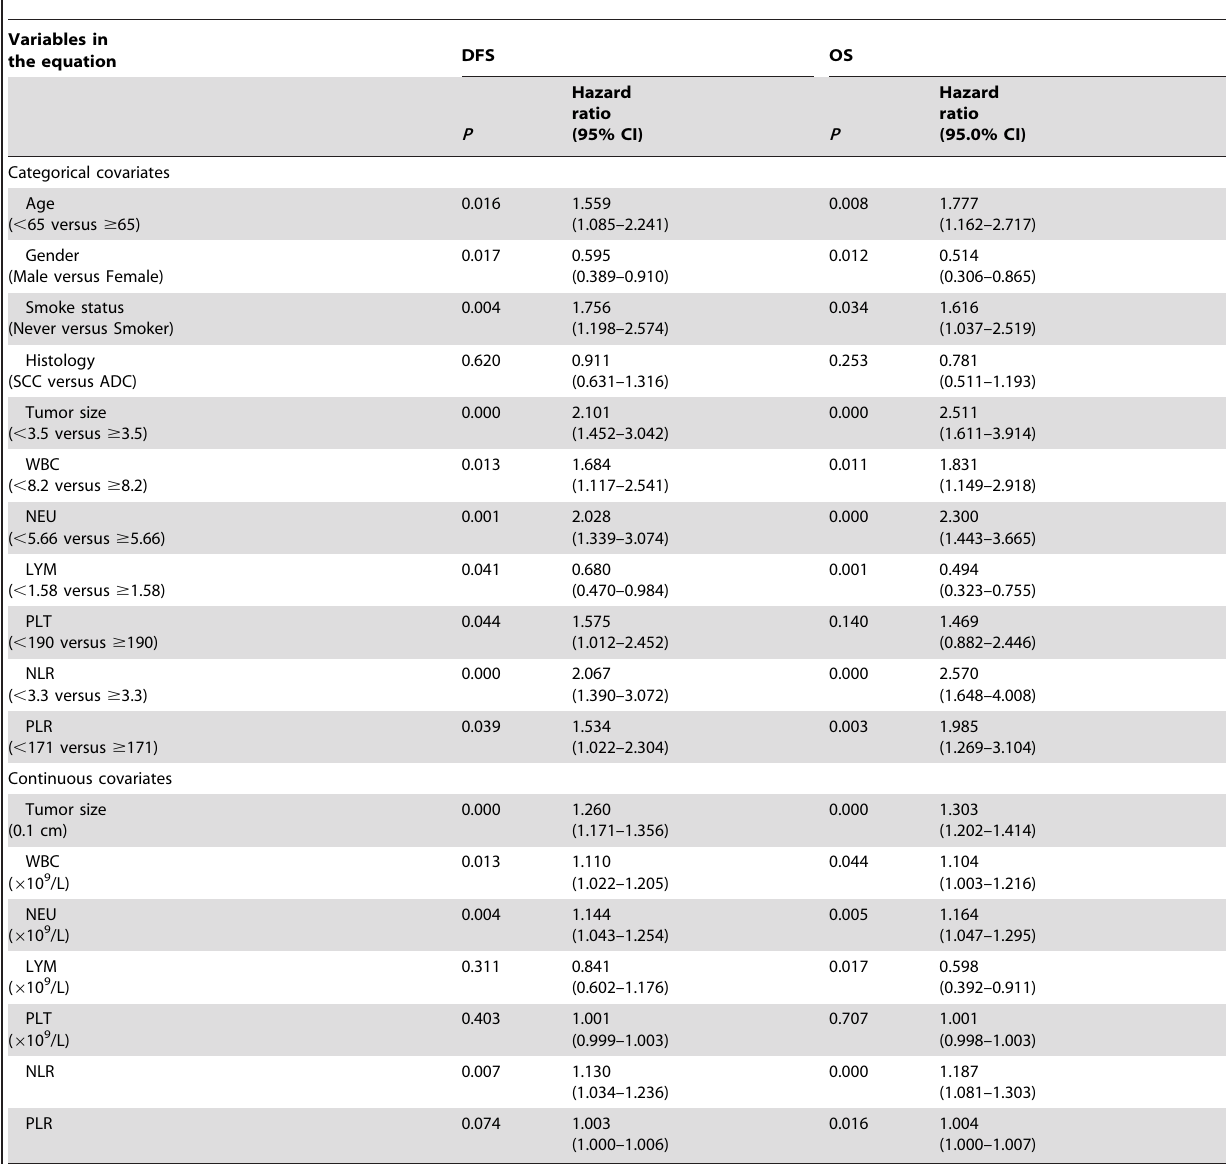
Table 3. Univariate proportional hazards (Cox) regression analyses according to DFS and OS.